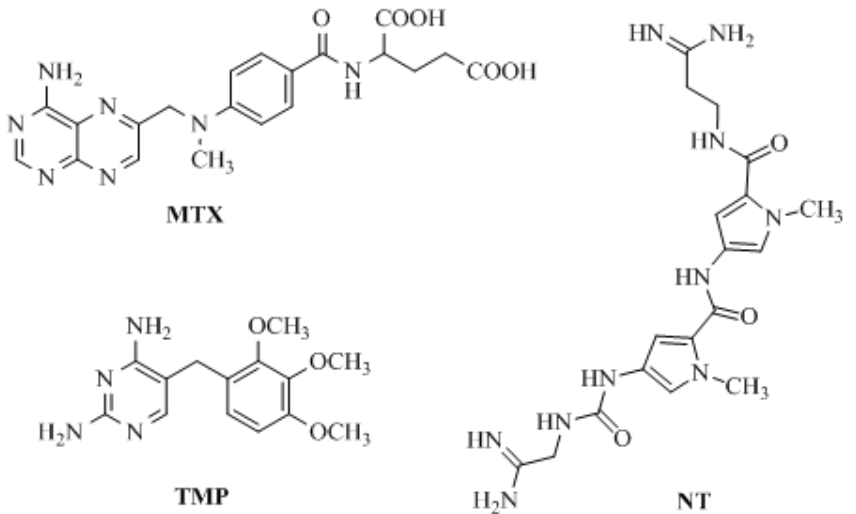
Figure 1. Structure of methotrexate (MTX), trimethoprim (TMP), and netropsin (NT) as model compounds.